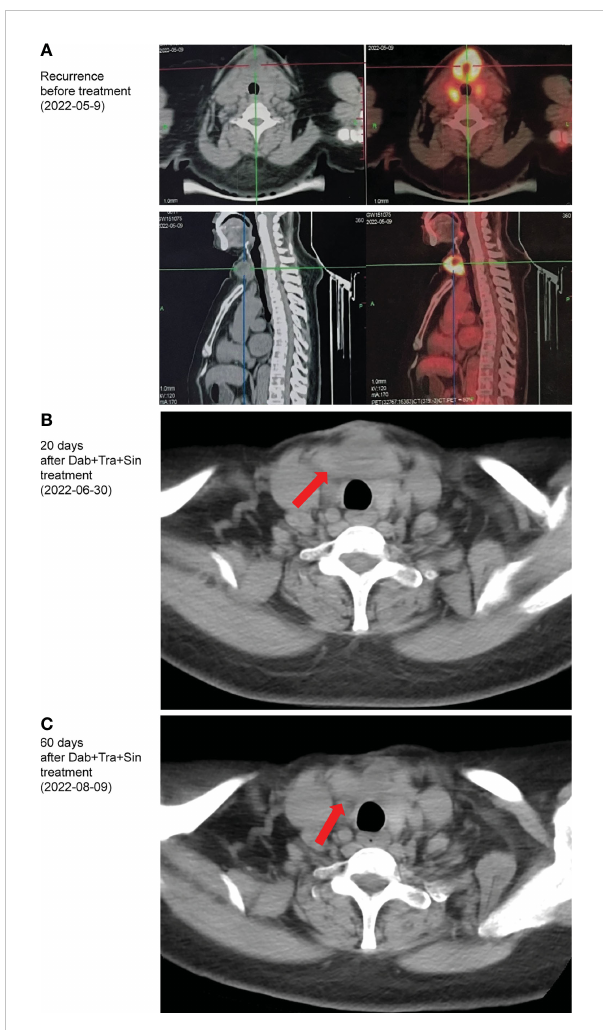
FIGURE 2 Computed tomography images showing the patient ’ recurrence (A) ,